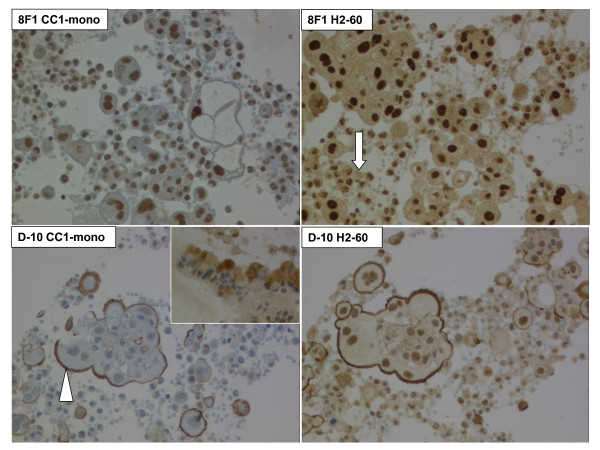
Anti-ERCC1 immunocytochemistry on cell block core of malignant pleural mesothelioma, using Mab 8F1 and D-10 with CC1-mono and H2-60 protocols. Arrow: Surrounding non-tumoral cells, including lymphocytes, macrophages and neutrophil granulocytes. Arrowhead: Unspecific plasma membrane staining with D-10. 200 × original magnification. Inset lower left: Staining of intracellular mucin vacuoles of a mucinous adenocarcinoma of unknown origin. 400 × original magnification.